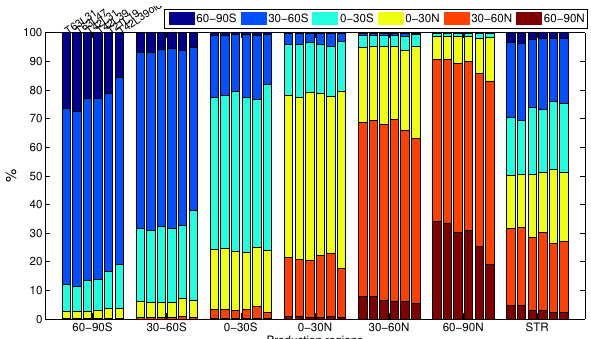
Fig. 12. Percentages of 10 Be deposited at a given latitude (’Deposition region’ shown in the legend) which were produced at the tropospheric latitudes indicated on the x-axis (’Production region’). Also shown is stratospheric (STR) production, averaged across all latitudes. The five bars at each latitude band show the model resolutions “T63L47”, “T42L39”, “T42L31”, “T21L19” as well as the “T42L39old”, published in Heikkil ¨ a et al. (2009), respectively.